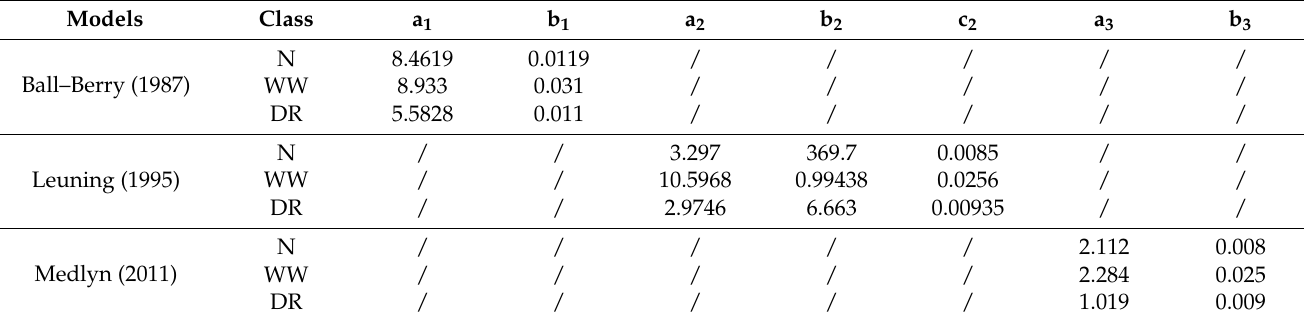
Table 3. Coefficients of the three stomatal conductance models for spring wheat under different water statuses, well water (WW), drought (DR), and all combined data